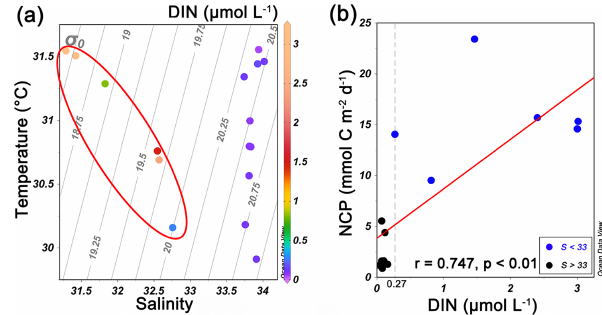
Figure 8. (a) T – S diagram of the surface DIN concentration in June 2015. The stations influenced by shelf water are in the red circle. (b) Correlation analysis between the surface DIN concentra- tion and NCP at sampling stations. The stations (characterized by S < 33) influenced by shelf water presented surface DIN concen- trations ≥ 0 . 27µmolL − 1 . Table 3. The start date and duration ( (cid:49) day) of shelf water intrusion at the stations with surface salinity lower than 33 in June